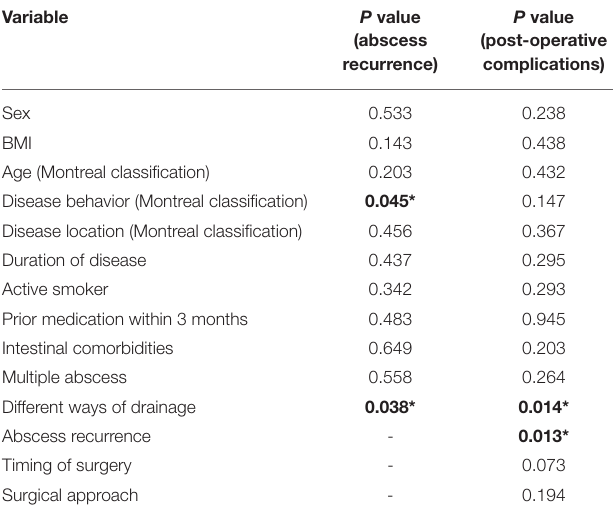
TABLE 4 | Risk factors of abscess recurrence after initial treatment of abscess and postoperative complications.